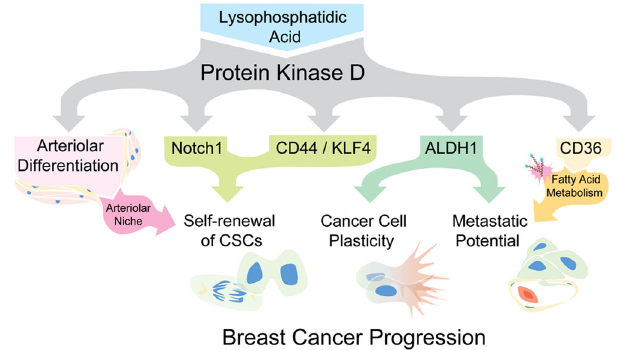
Fig. 8 LPA/PKD-1 signaling in the development of an arteriolar niche within the tumor microenvironment and cancer stem cell expansion in estrogen receptor-positive breast cancer. A proposed mechanistic model shows that the LPA/PKD-1 signaling regulates arteriolar differentiation within TME, CSC plasticity, and